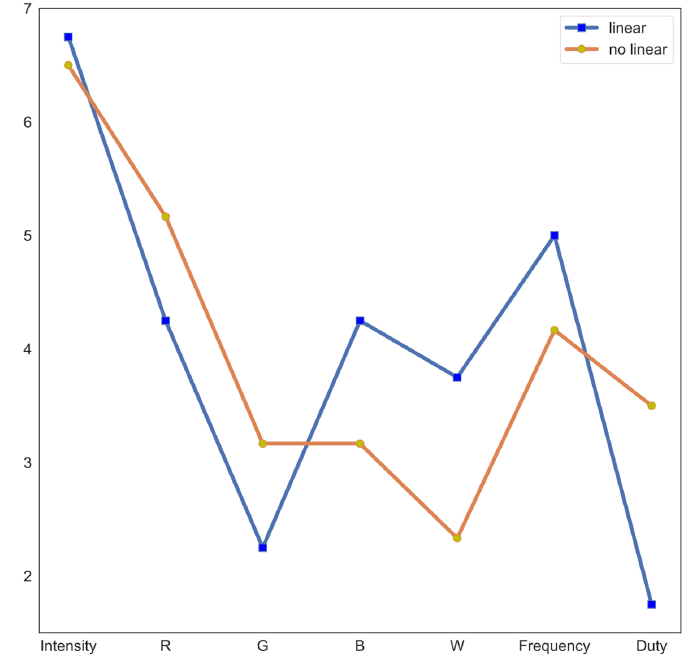
Figure 8. Feature elimination order distributions with algorithms from the two models used.